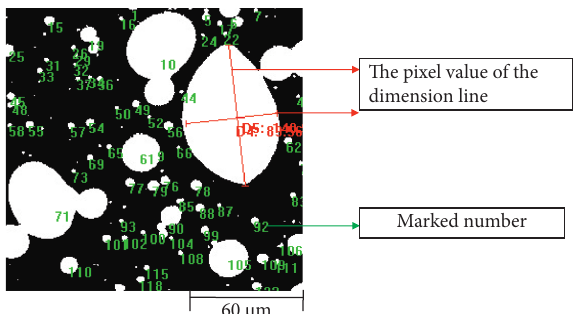
Figure 9: Fluorescence microscopic binarization image of SBS modified asphalt with 0% content of APR.